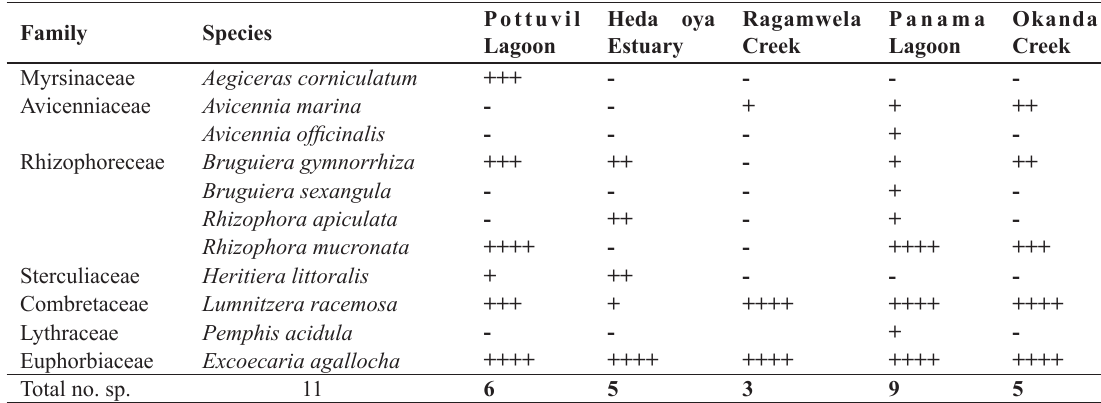
Table 2: Abundance and Distribution of Mangroves in Selected Sites.